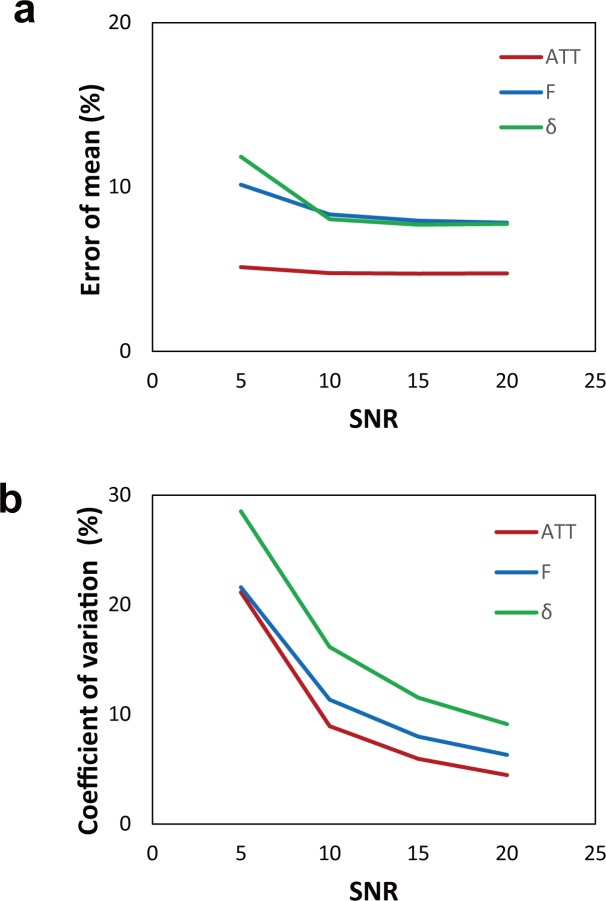
Monte Carlo simulation results for the bSSFP model.The error percentage of the mean (indicating the accuracy) (a) and the coefficient of variation (indicating the precision) (b) are shown as a function of the signal-to-noise ratio (SNR) that ranged from 5 to 20 with a step size of 5.